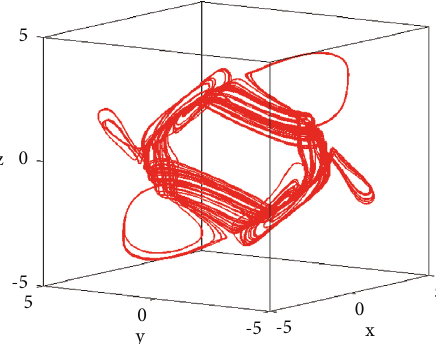
Figure 9: Chaotic attractor of system (4) on 3D projections when � 0 . 89 and q q 1 and b � − 9 and the IC ( x